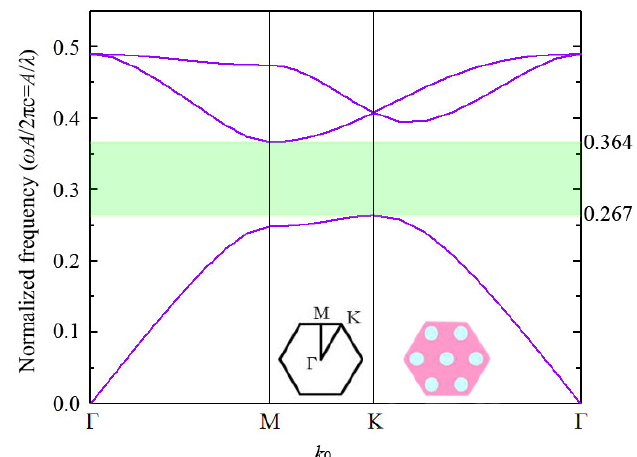
Figure 4. The PBG of the PhC with r 0 = 0.19 a .